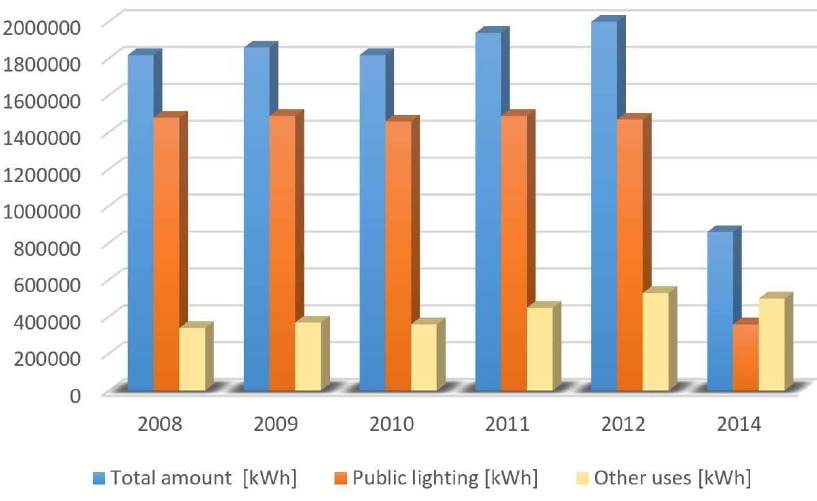
Figure 4. Impact of the smart lighting technology in